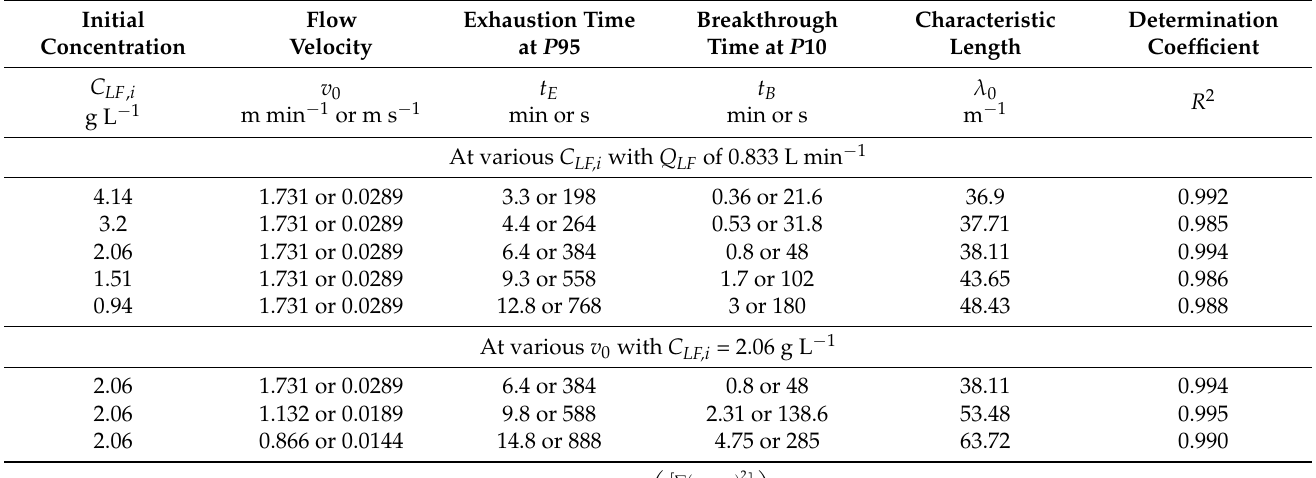
Table 1. Parameters for prediction of the operation of high-gradient magnetic separator (HGF-10